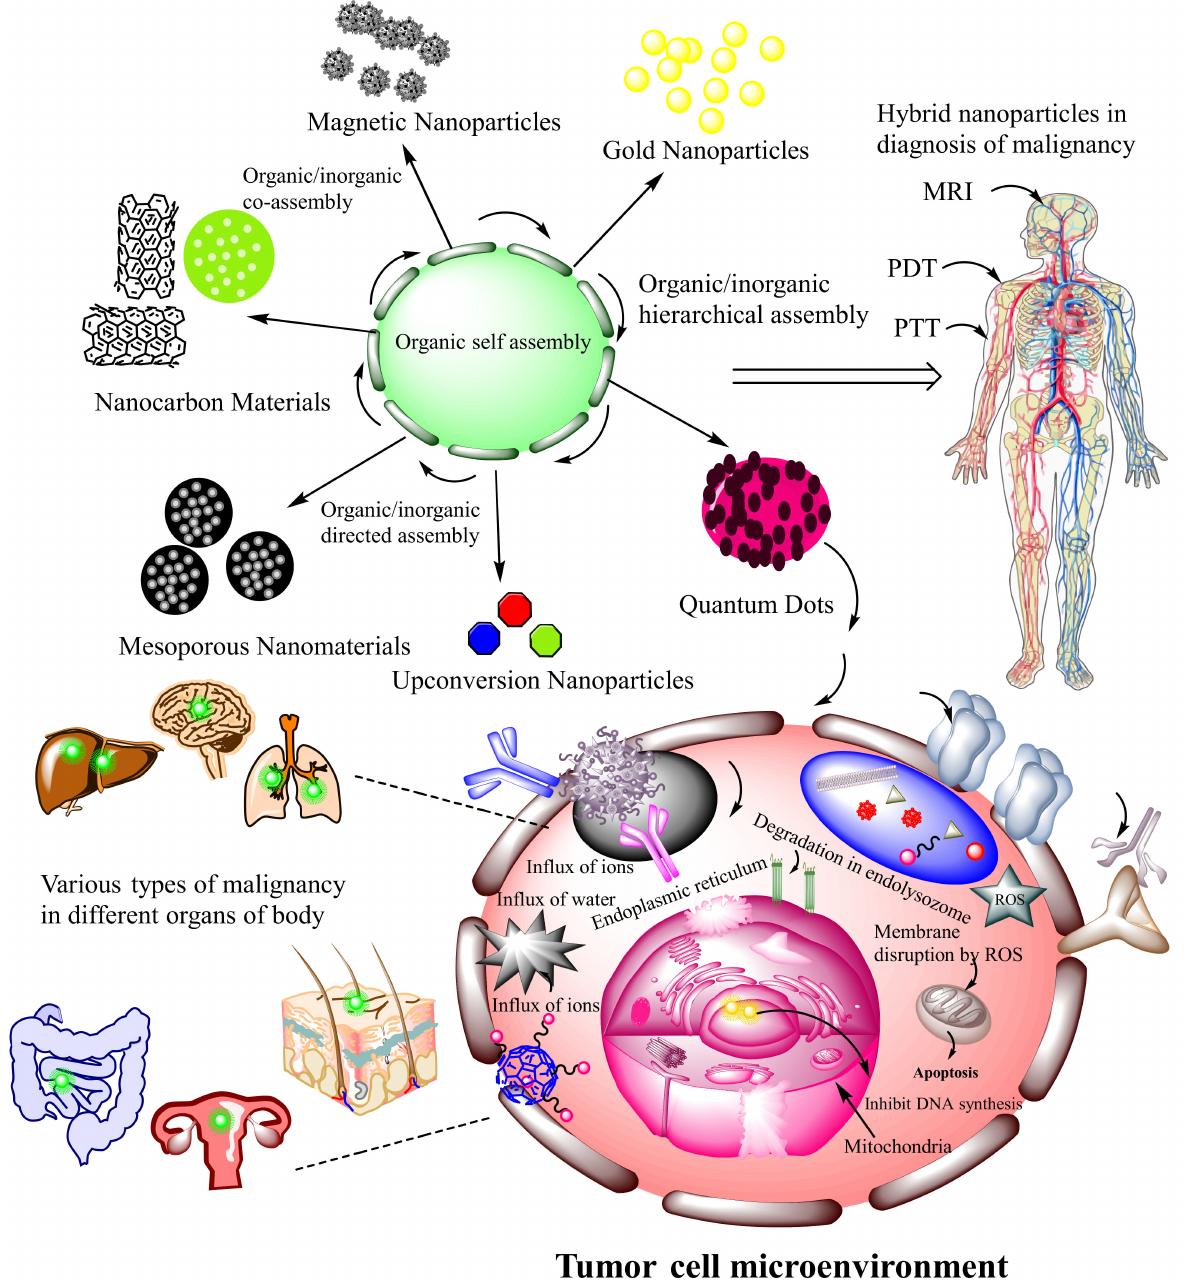
Figure 5. Showed types of hybrid nanoparticles for tumor targeting and